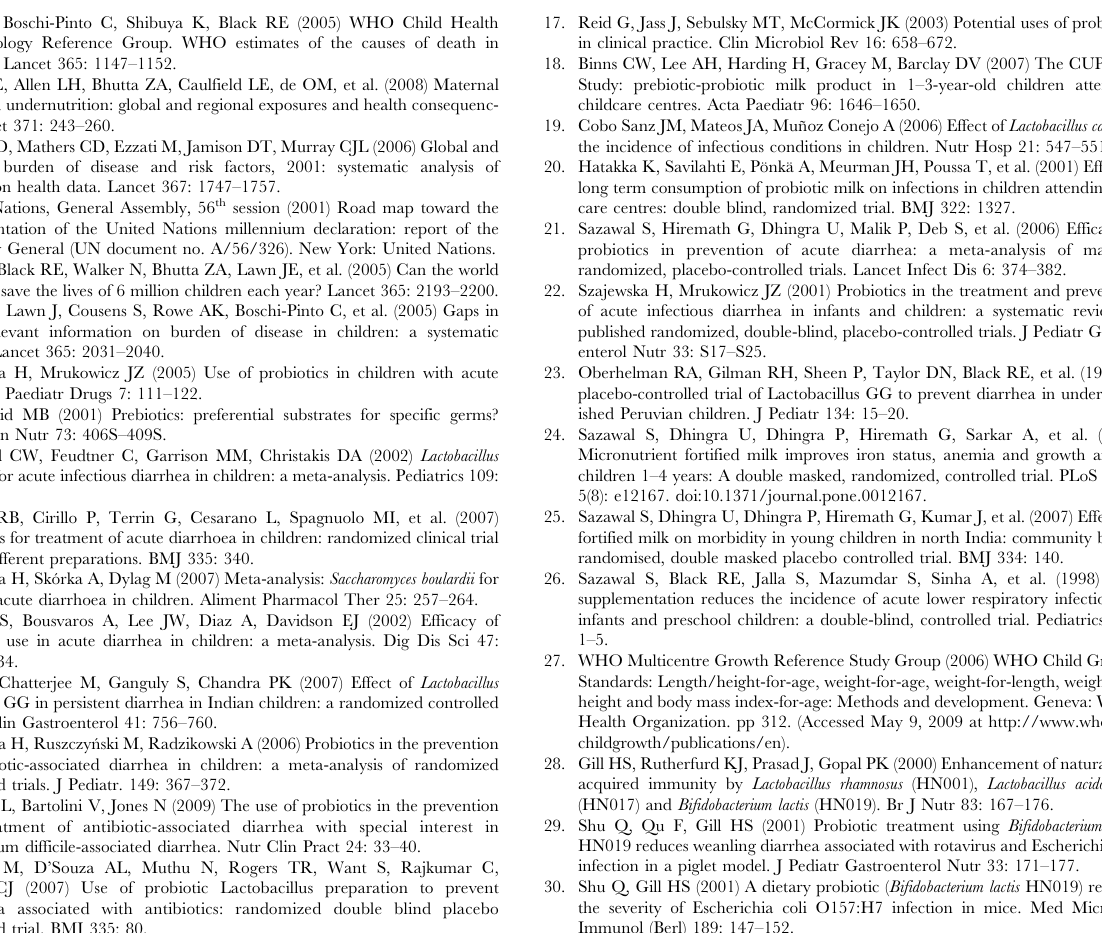
Table S4 Effect of prebiotic oligosaccharide and probiotic Bifidobacterium lactis HN019 and fortified milk on common childhood morbidities (among non anemic children).